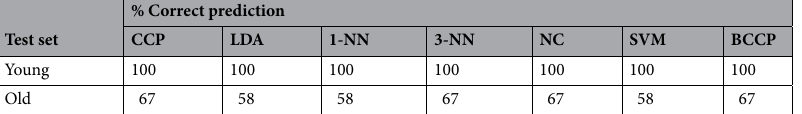
Table 1. Performance of seven classifier algorithms using greedy pairs gene selection with the “mixed” training set. CCP compound covariate predictor, LDA linear discriminant analysis, 1-NN 1-nearest neighbor, 3-NN 3-nearest neighbors, NC nearest centroid, SVM support vector machines, BCCP Bayesian compound covariate predictor.